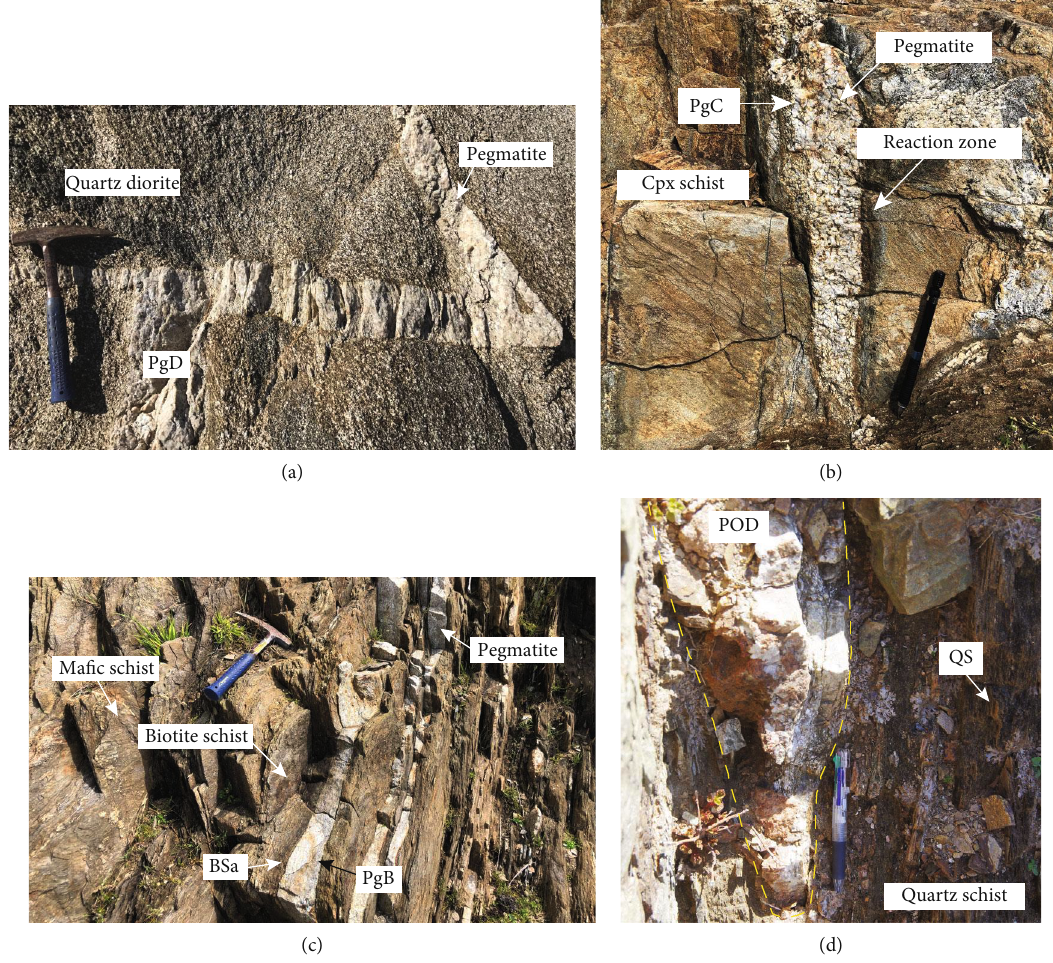
Figure 2: Outcrop photographs of (a) pegmatites in quartz diorite (PgD), (b) a pegmatite (PgC) intruded into ma fi c schist marked by a reaction zone at the pegmatite border, (c) pegmatites intruded subparallel to the foliation in schist, and (d) a garnetite pod (POD) in quartz schist (QS). PgD: Qz diorite-hosted pegmatite; PgC: Cpx schist-hosted pegmatite; PgB: Bt schist-hosted pegmatite; BS: Bt schist; QS: Qz schist; POD: garnetite pod. Table 1: Mineral assemblages and modal abundances (area%) of all sample groups from Kinkasan Island.